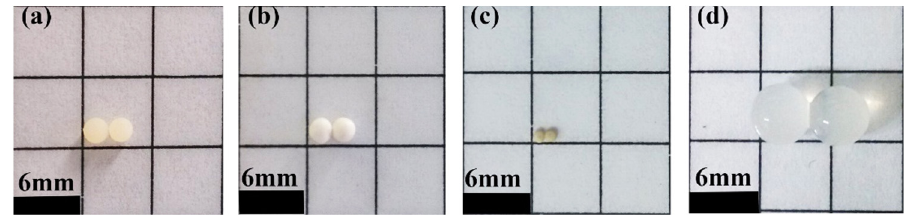
Figure 4. The pictures of the composite alginate gel: ( a ) alcogel, ( b ) aerogel, ( c ) xerogel, and ( d ) swelling state of the aerogel.